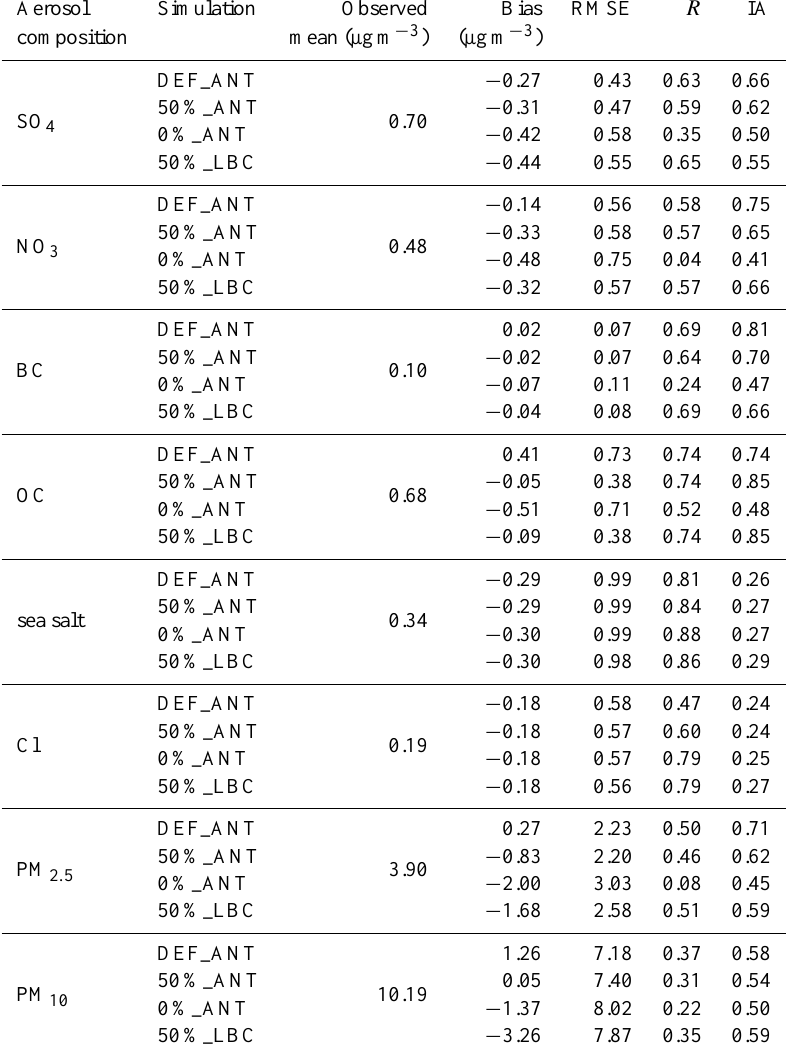
Table 10. Performance of simulated PM 2 . 5 at the IMPROVE monitoring sites in terms of bias, root-mean-square error (RMSE), correlation coefficient ( R ), and index of agreement